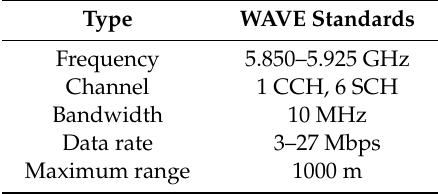
Table 4. Vehicular wireless communications